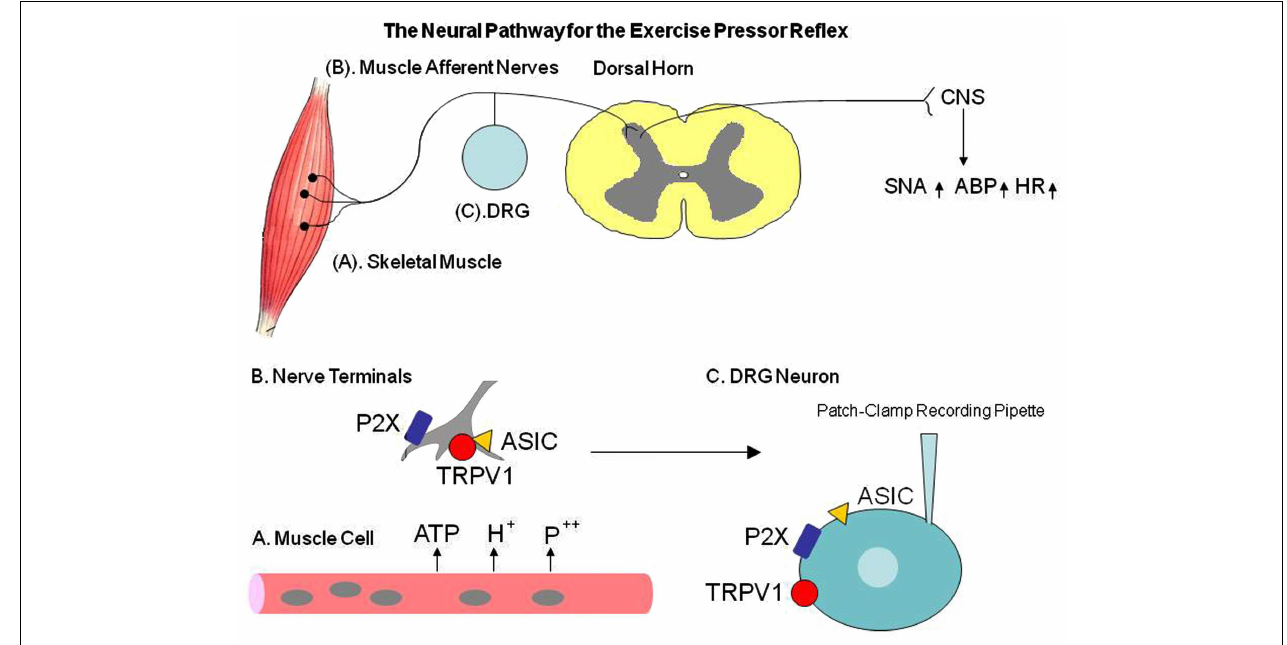
responsiveness in the primary afferent neuron of control rats and PAD rats.Those receptors appear at the peripheral terminals and cell body of the DRG (sensory afferent neurons).The receptor activity in the DRG cell body can be used to reflect its effect in the nerve endings.TRPV1, transient receptor potential vanilloid type 1; ASIC, acid sensing ion channel; SNA, sympathetic nerve activity; ABP, arterial blood pressure; HR, heart